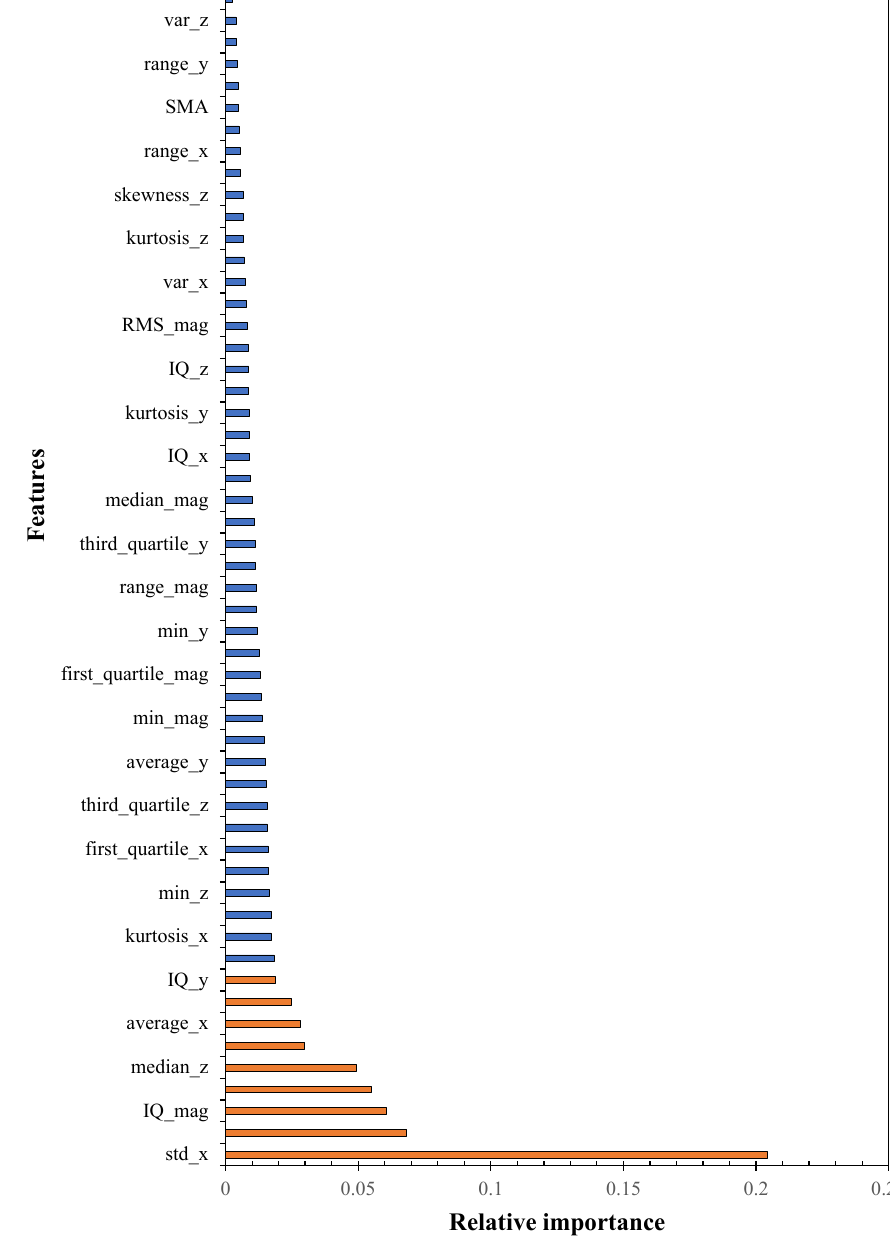
Figure 5. The relative importance of 55 features extracted from accelerometer signals.